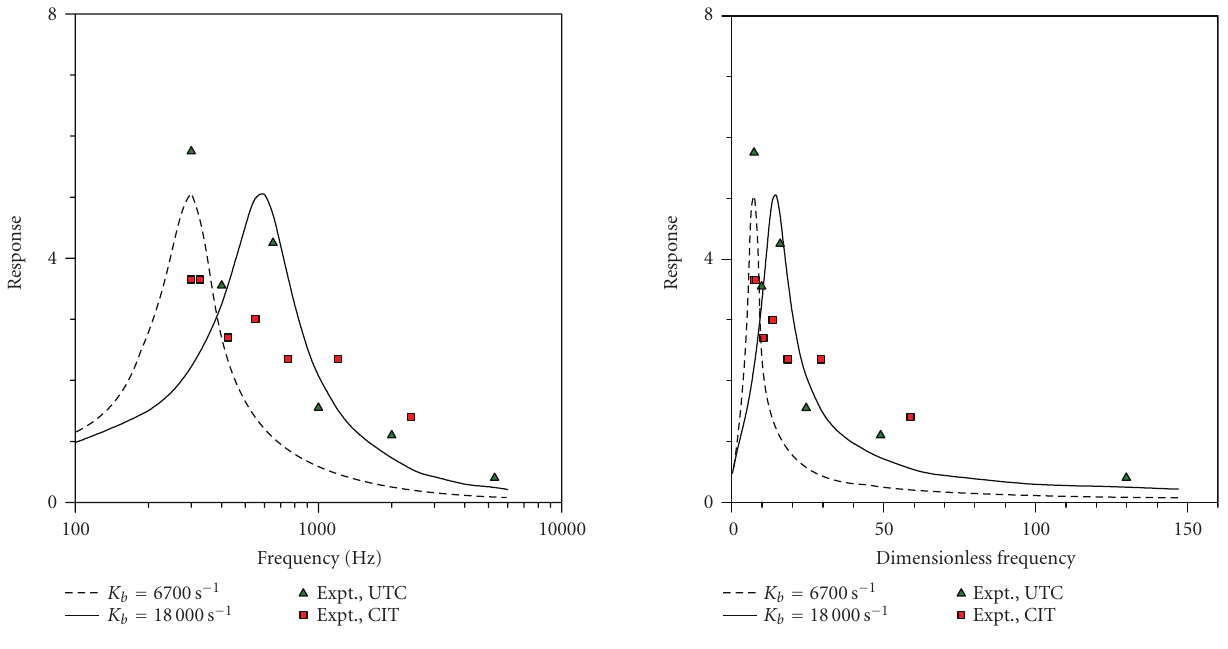
Figure 7: Frequency response of AP/PBAN Propellant C, theory ( K b = 6700 s − 1 , Δ H s = 115 000J/kg; K b = 18000 s − 1 , Δ H s = 68 000J/kg) and experiment [24], in terms of real part of pressure- based function (theory & experiment, pressure at 300psig).